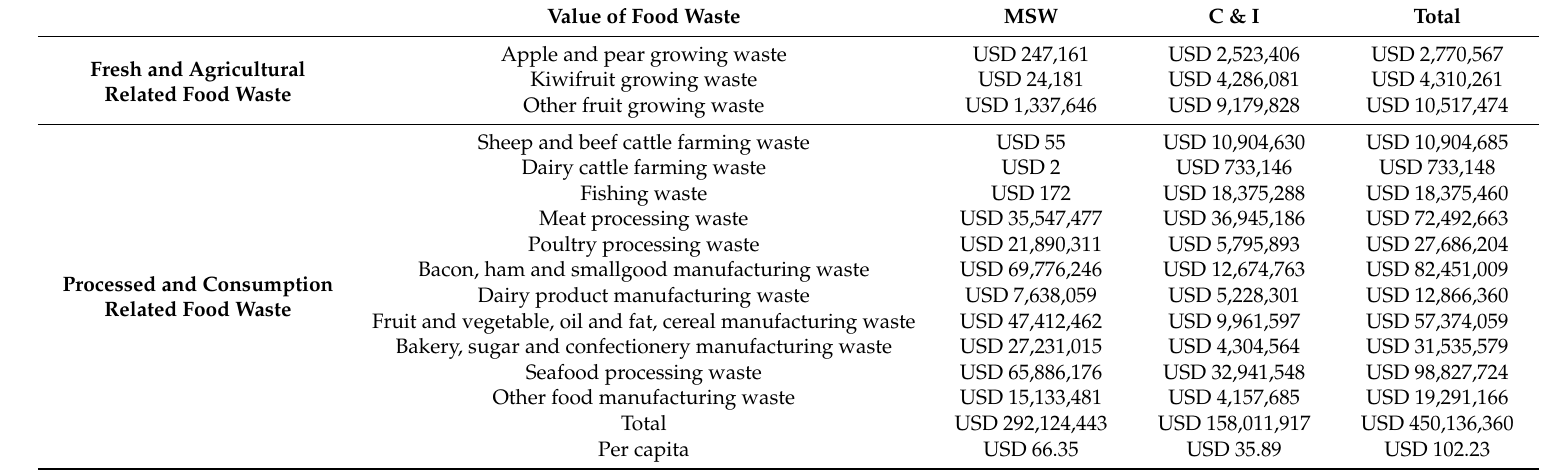
Table 2. Value (US Dollars) of food waste generated in New Zealand in 2011.